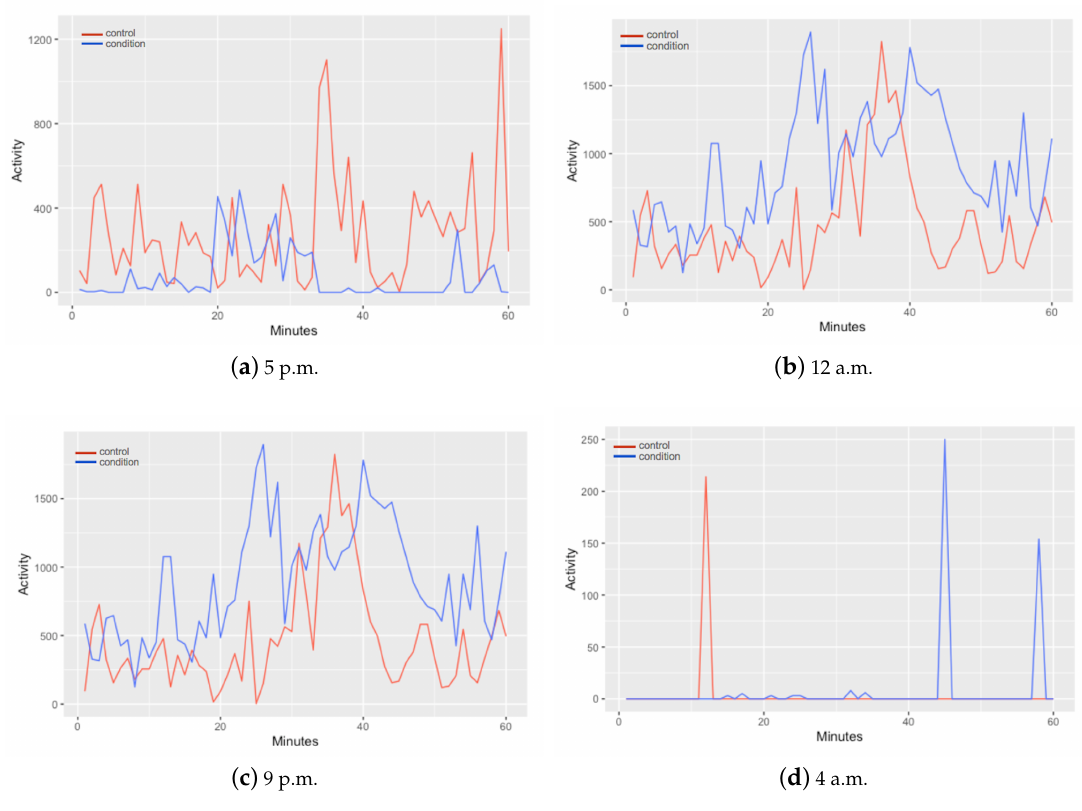
Figure 2. Comparison of motor activity in different hours of the day between a control an a